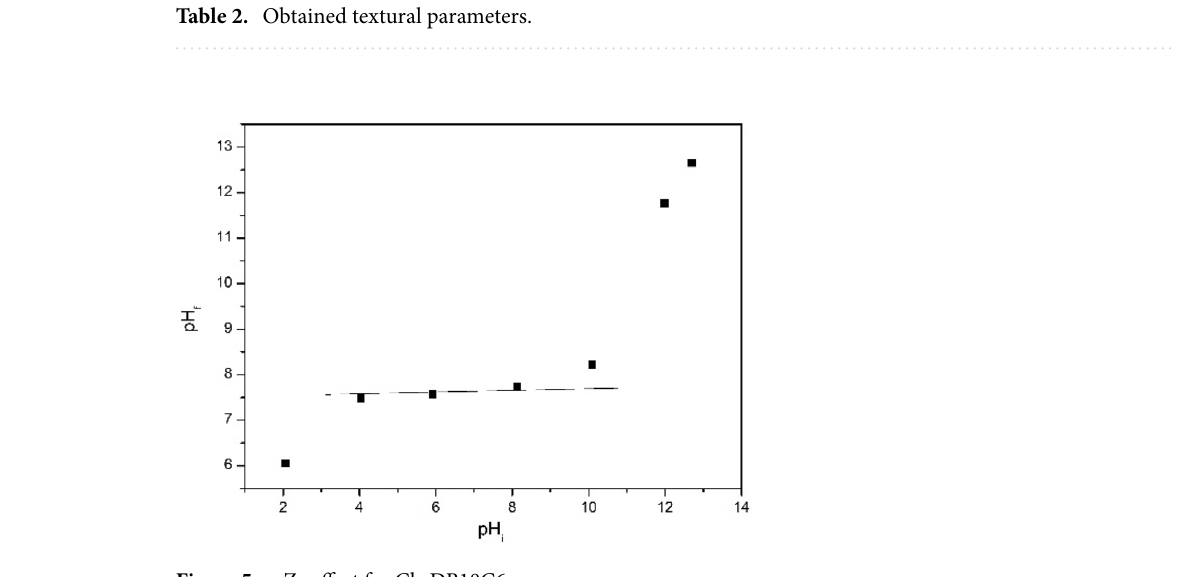
Figure 5. pZc effect for Ch-DB18C6.